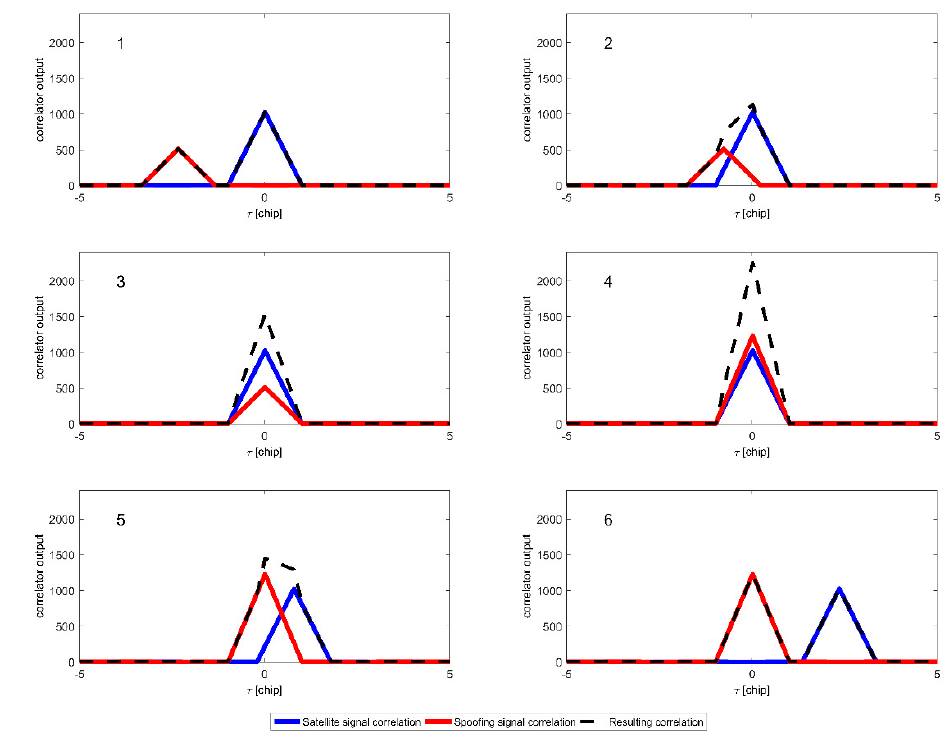
Figure 1. Correlator output during early phase of intermediate spoofing: code phase alignment (1–3), taking control over code tracking loops (4), carry-off – moving the correlation peak away from the true position (5-6).